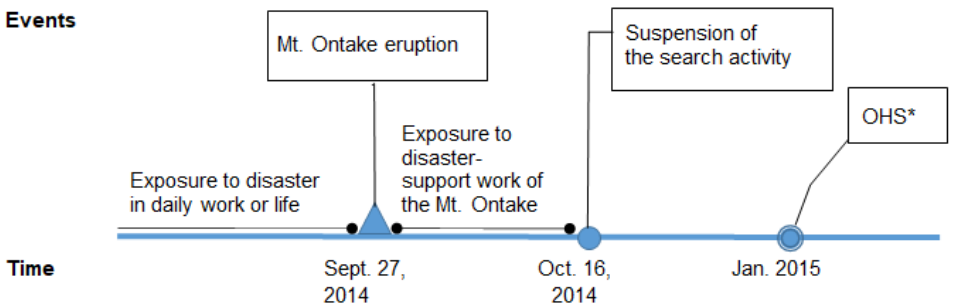
Figure 1. Exposure to the disaster and the time of investigation. *OHS: Health survey on disaster stress related to the Mt. Ontake eruption disaster-support work.